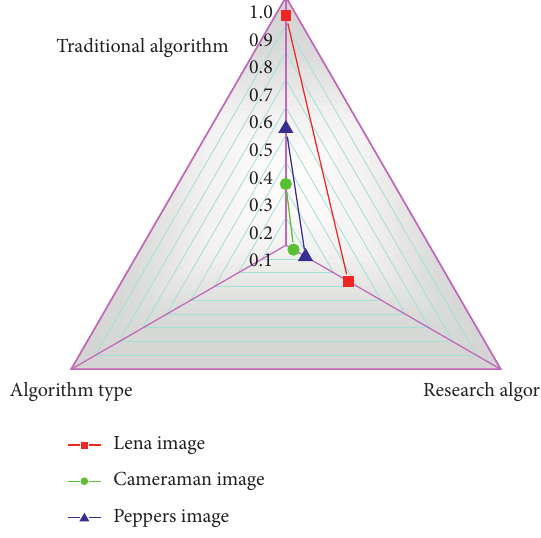
Figure 8: Optimal threshold finding average time.